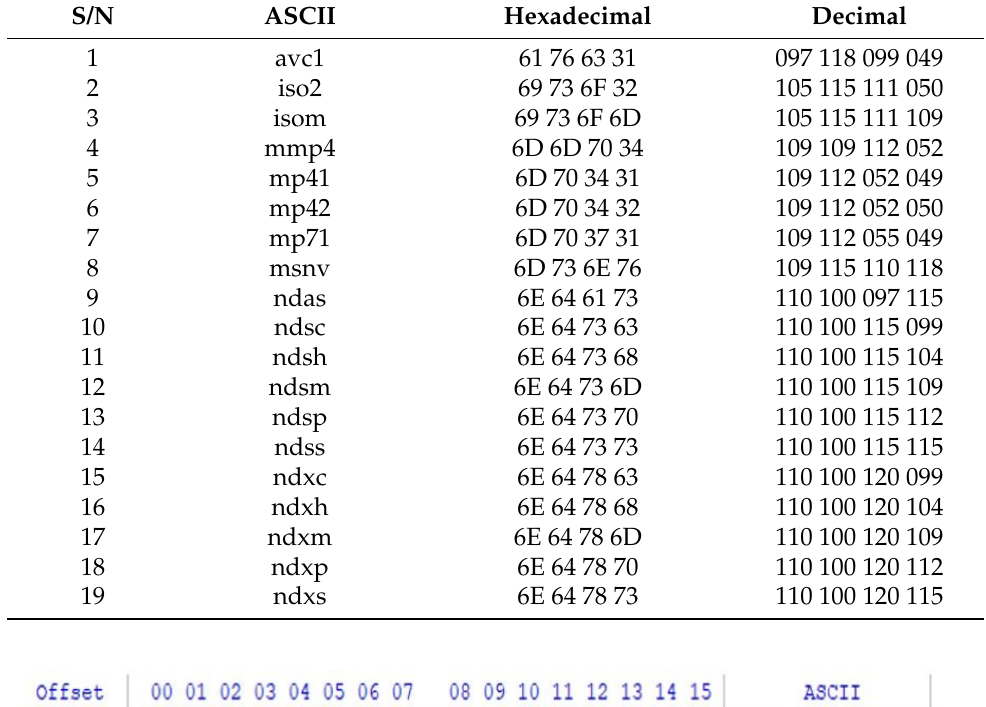
Table 2. Signature sub-type of MP4 files.